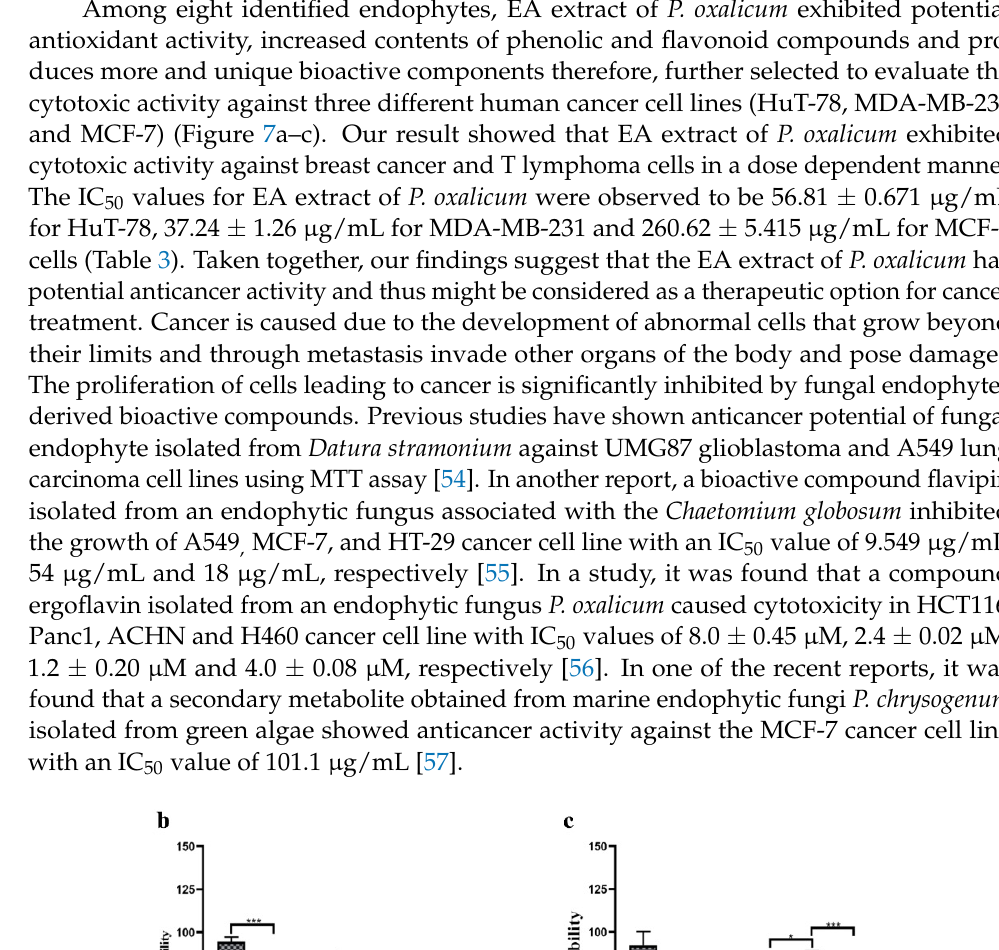
Isolated Strains